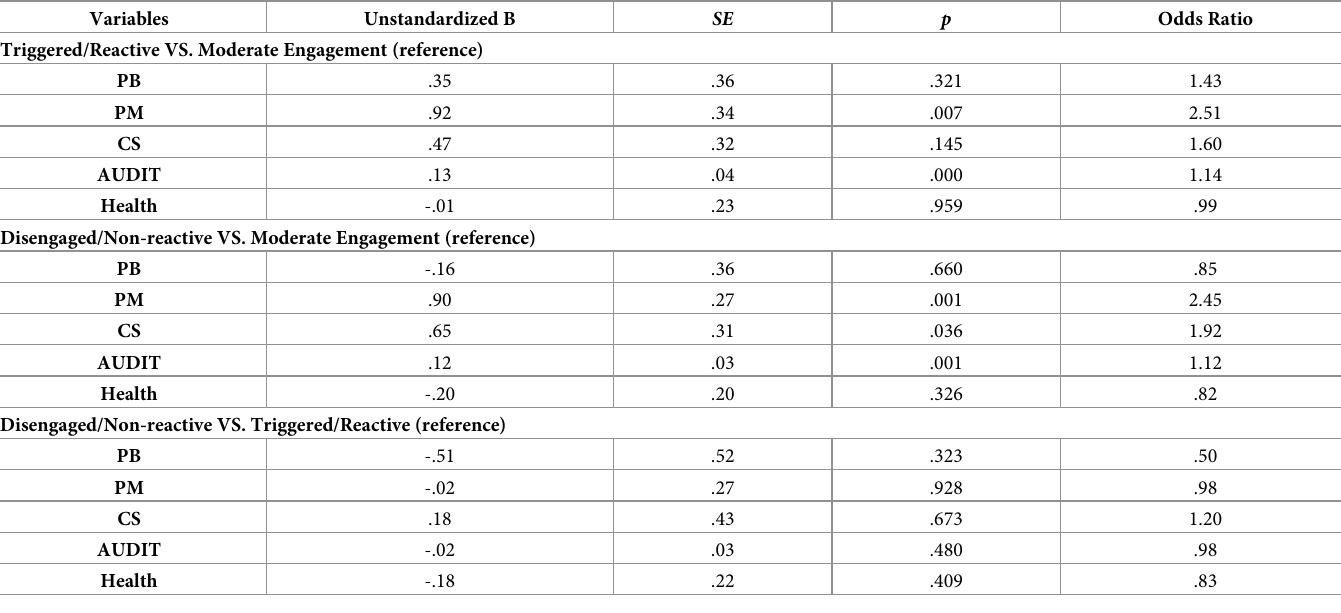
Table 4. Prediction of latent class membership by racial socialization dimensions and health indicators.